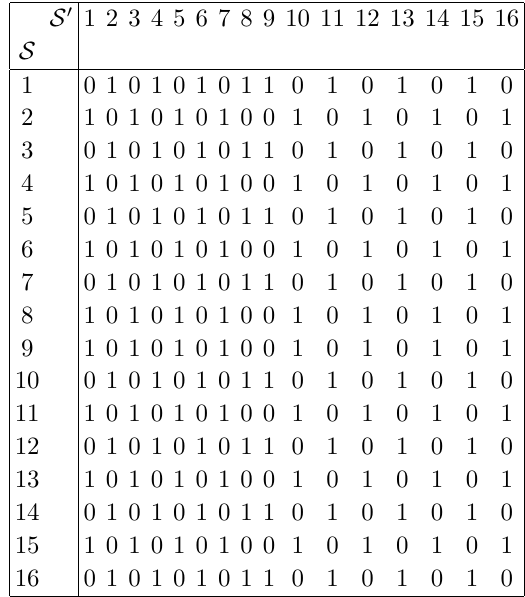
Table 22 . Gadget values for P